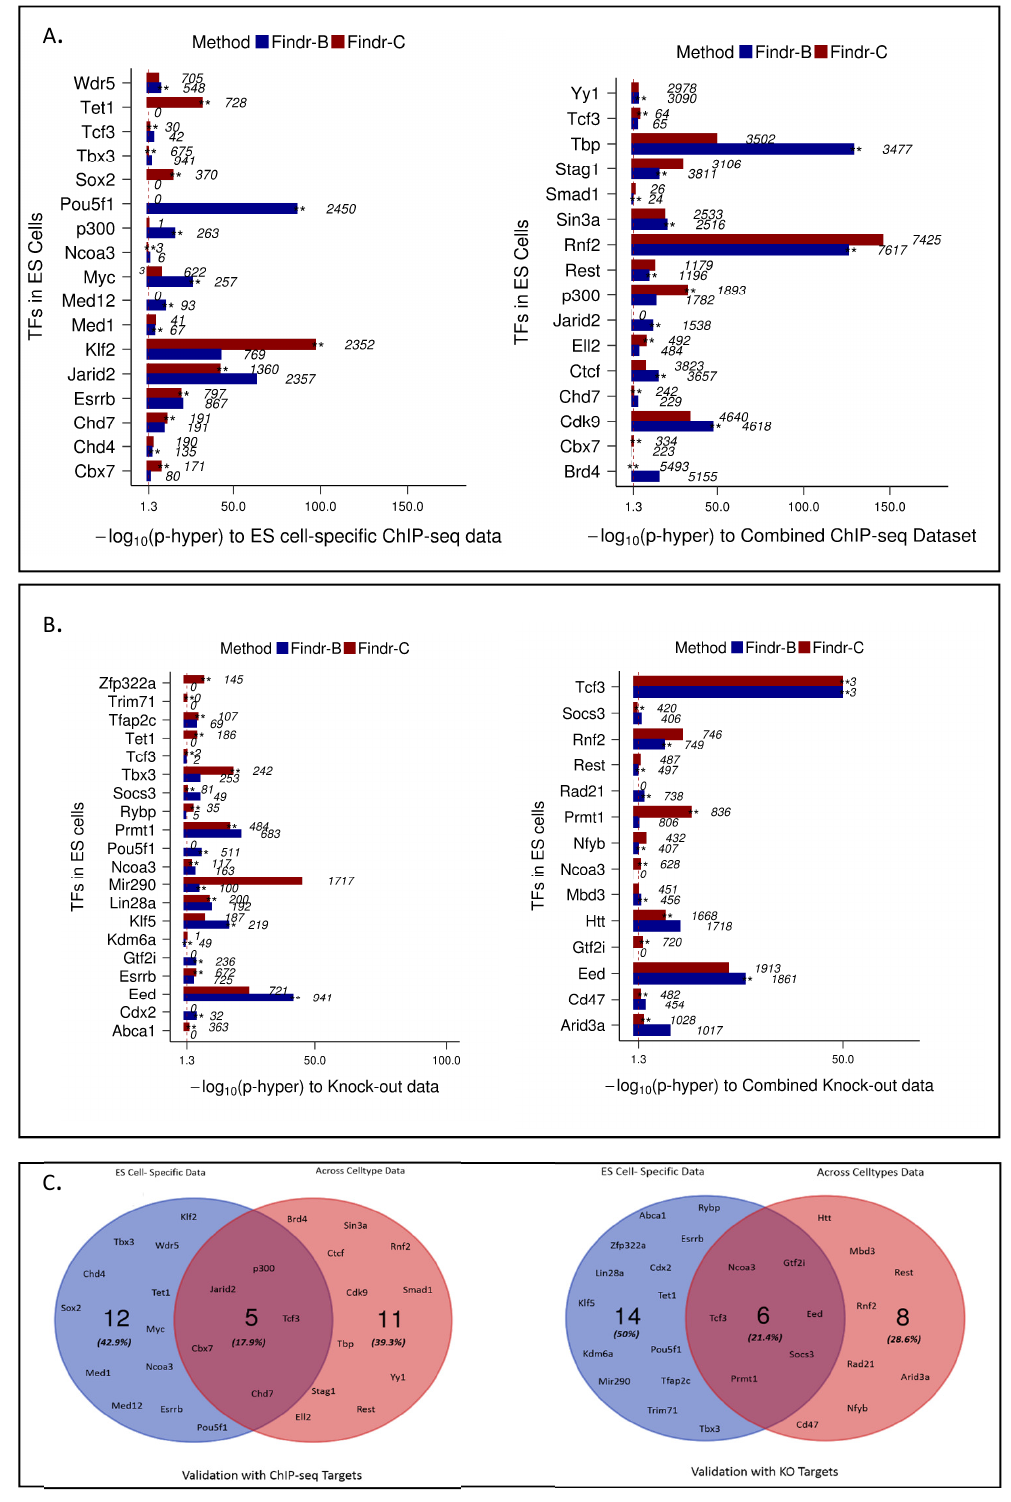
Figure 4. Comparison of Findr-adaptive (A) predictions using mouse ES cells and all cell types samples. ( A ) Bar plots representing enrichments for Findr-B, -C and -A predictions using ChIP-seq data as a validation dataset for ES cells (left) and all cell types (right). ( B ) Bar plots representing enrichments for Findr-B, -C and -A predictions using knock-out data as a validation dataset for ES cells (left) and all cell types (right). ( C ) Overlap of factors between ES and all cell types using ChIP-seq (left) and knock-out (right) as validation